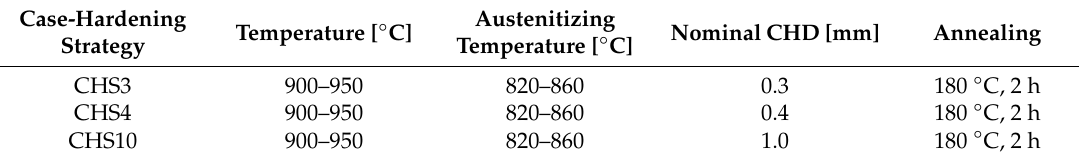
Table 4. Detailed listing of the applied case-hardening strategies, which were carried out at H-O-T in Nuremberg. Nuremberg.